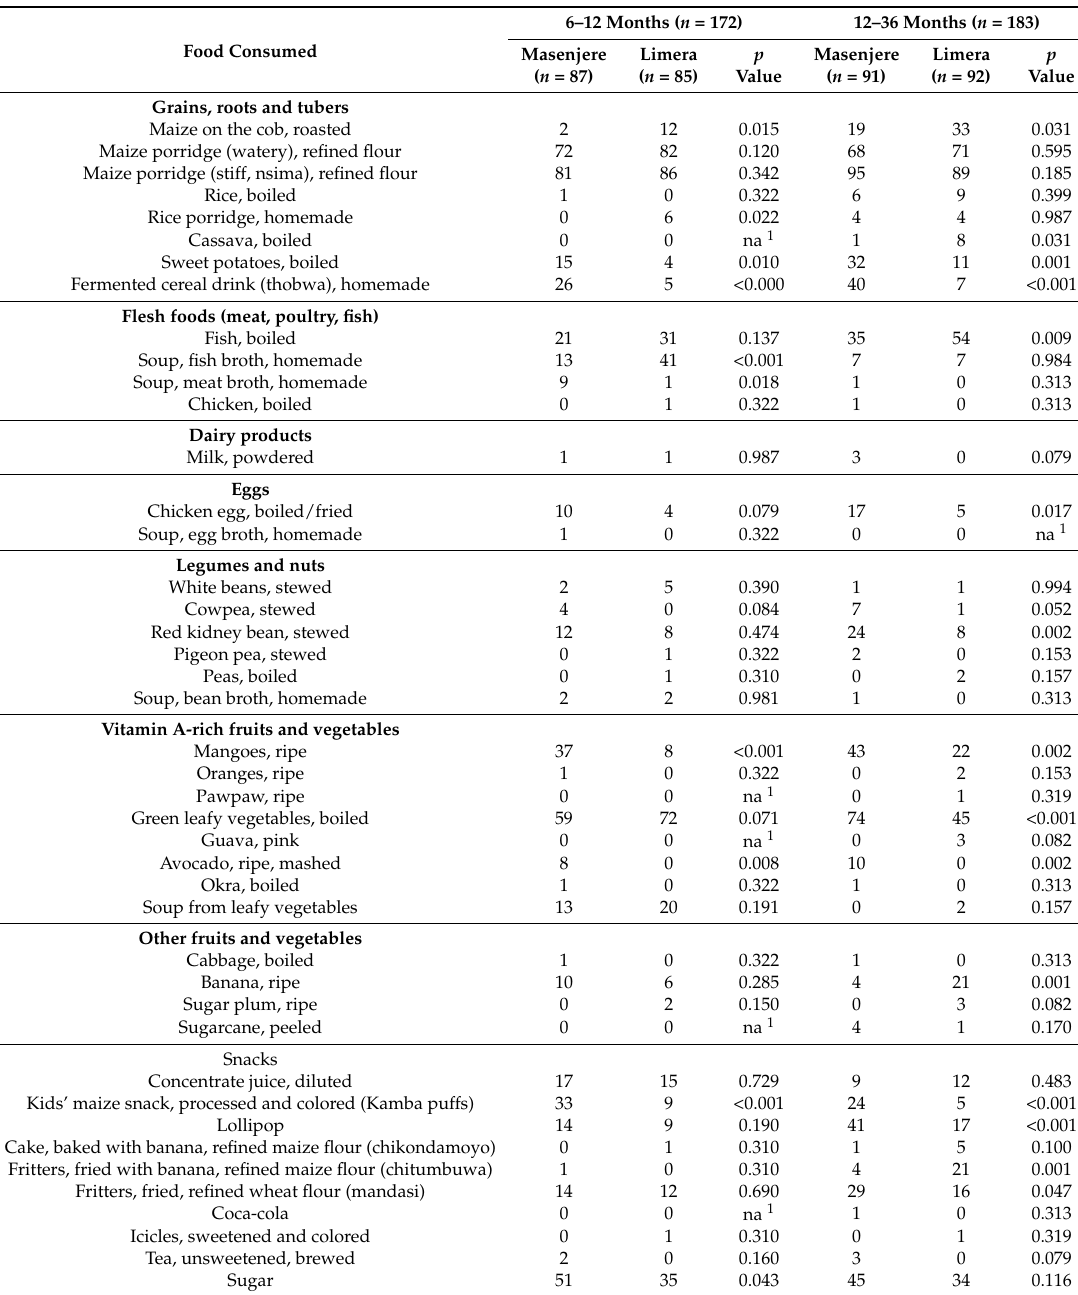
Table 2. List of the type of foods consumed and their frequency of consumption by 6–36-months-old children from Masenjere and Limera